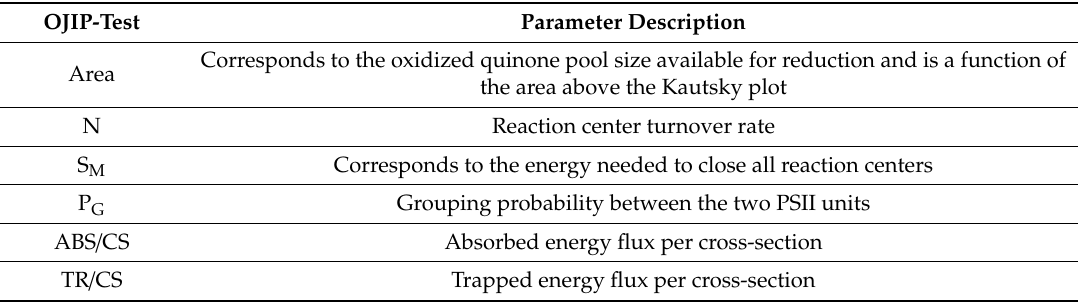
Table 1. Summary of fluorometric analysis parameters and their